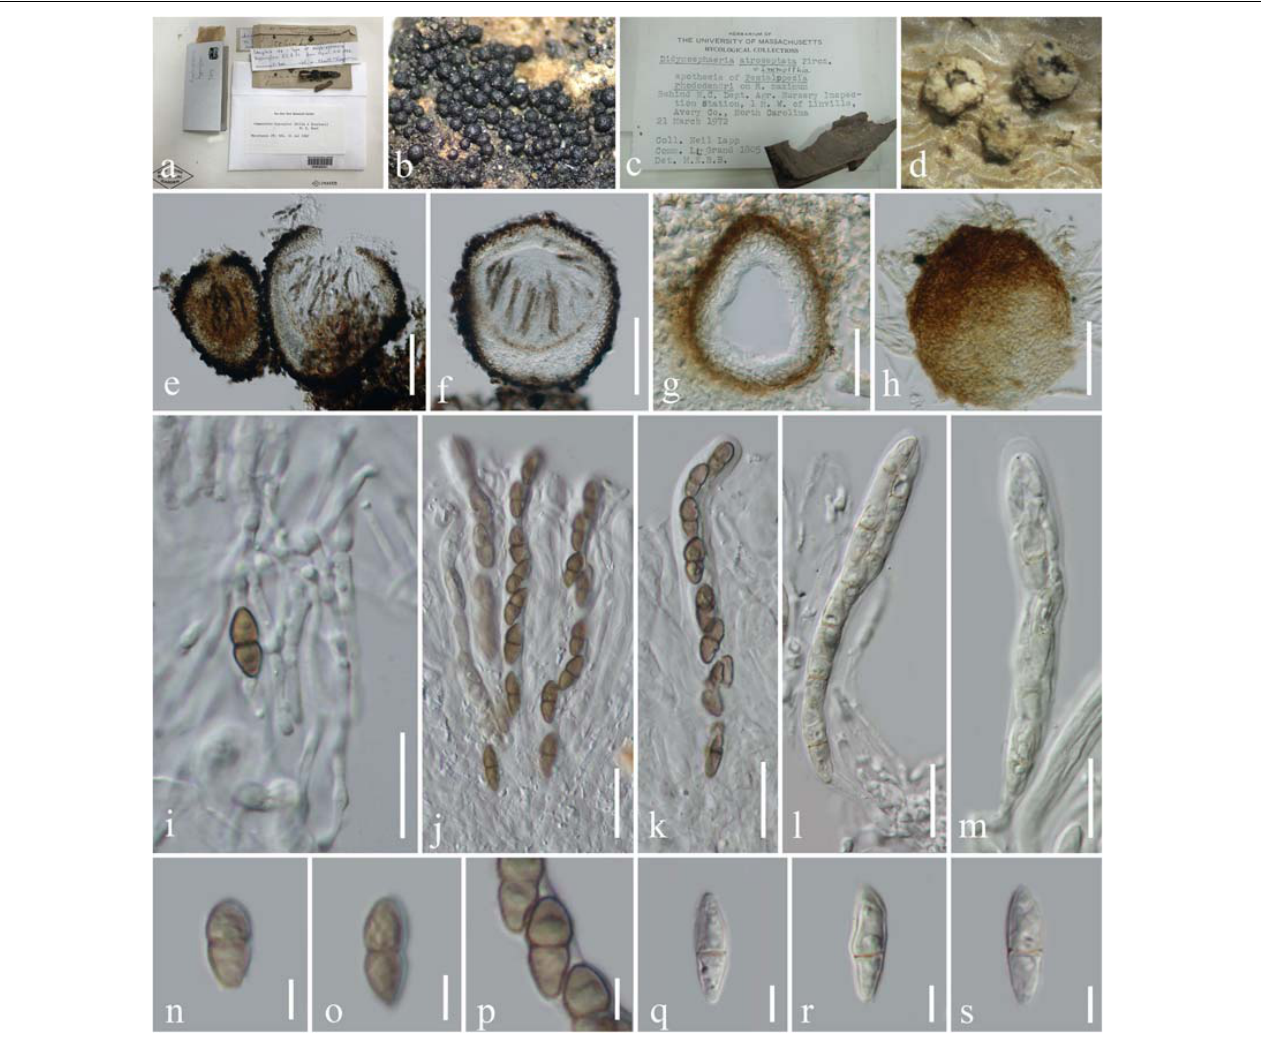
FIGURE 1 | Morphological characteristics of Immotthia . (c,d,g,h,j,k,q–s) Immotthia atroseptata (DAOM 13900; holotype of Didymosphaeria atroseptata ). (a,b,e,f,i–k,n–p) Immotthia hypoxylon (NY00830041, holotype of Amphisphaeria hypoxylon ). (a,c) Herbarium label and specimens. (b,d) Appearance of ascomata on host substrates. (e–g) Section through ascomata. (h) Exterior of ascoma. (i) Pseudoparaphyses. (j–m) Asci. (n–s) Ascospores. Scale bars: (e,f) = 100 µ m, (g,h) = 30 µ m, (i–m) = 20 µ m, and (n–s) = 5 µ m.